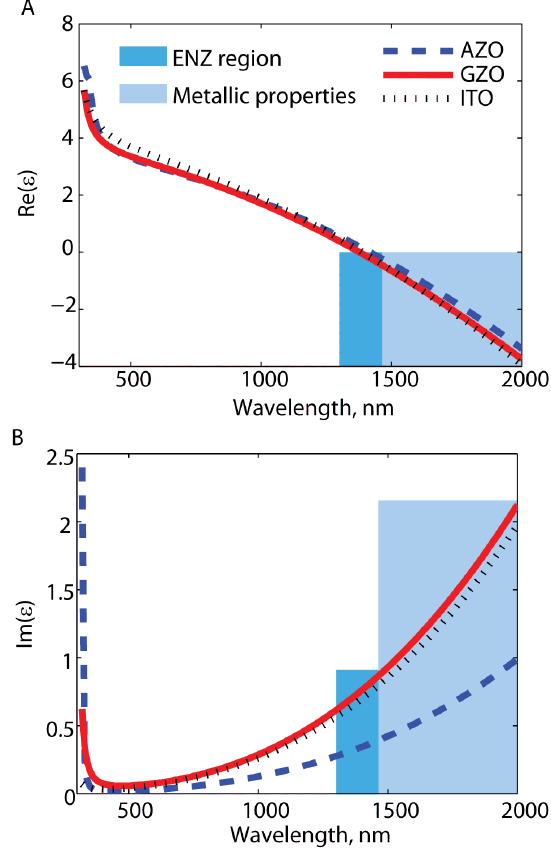
Figure 2: Strong dependence of AZO permittivity [real (A) and imaginary (B) parts] on oxygen pressures upon deposition (0.1– 50 mTorr). The value can be changed up to several units. The film thickness is approximately 120 nm. Losses in AZO is several times lower then losses of silver (Ag) at telecommunication